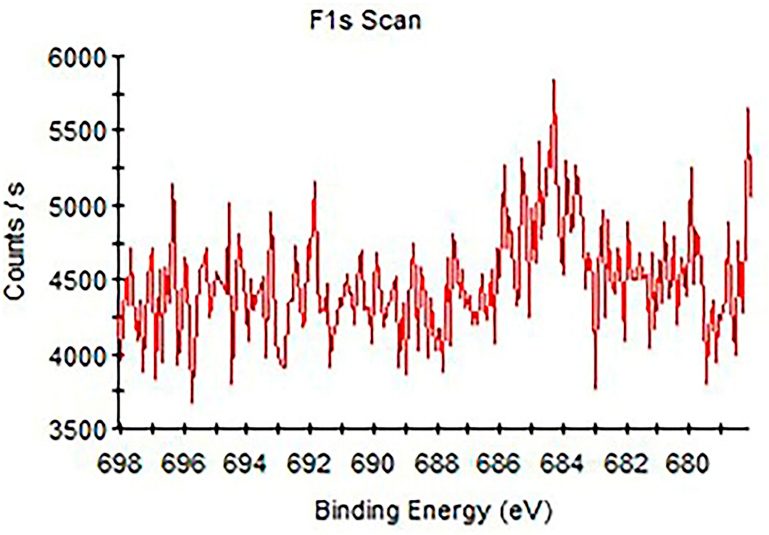
Figure 4. High resolution of XPS spectra of F 1 s for bleached enamel surface and subsequent fluor- idated toothpaste containing bioglass (NovaMin) application for a period of 45 days (Group 1).